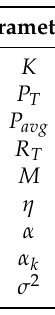
Table 1. Values of Simulation Parameters.